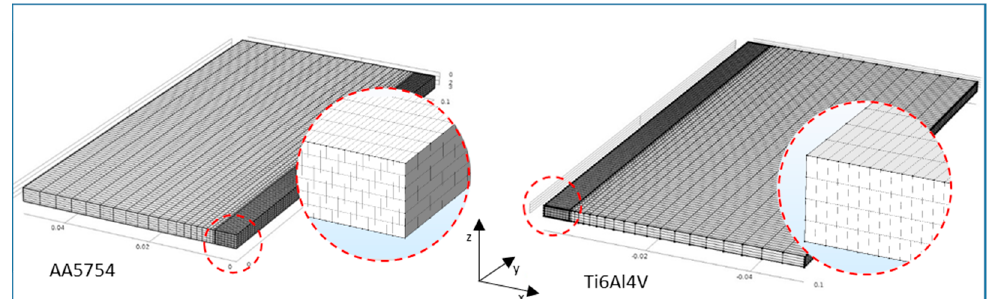
Figure 2. Mesh outlook.